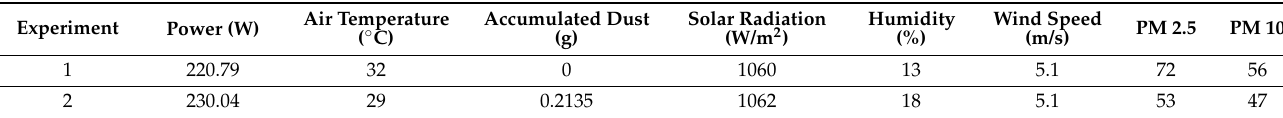
Table 5. Conditions and numerical results of the experiments performed to study the effect of air temperature and dust on performance of the panel.